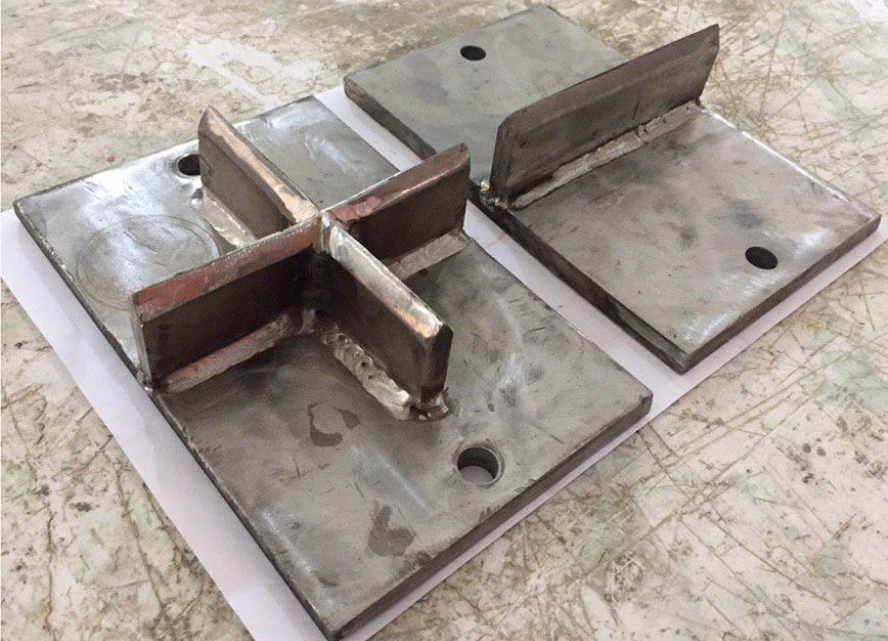
Figure 11. Suggested line and cross load-transferring plates of Abid et al. [69].